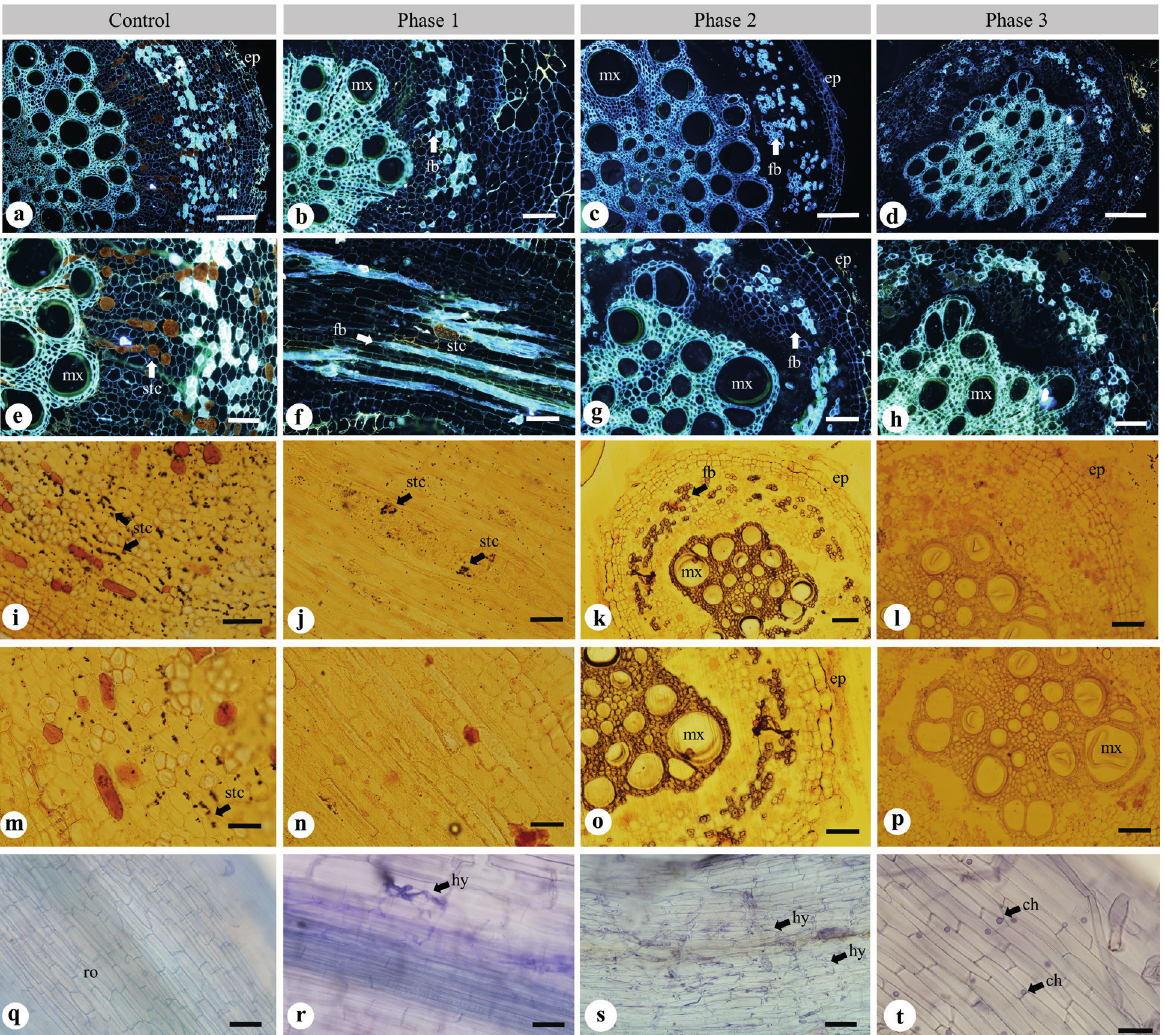
Figure 6 - Anatomical aspects of non-grafted P. edulis in three stages of Fusarium wilt. ( a-e ): fluorescence microscopy of the root of control plants not inoculated showing the presence of fibers and starch. ( b-f ): first wilt stage with marked reduction in the presence of starch and absence of callus. ( c-g ): absence of starch and callus and lower fluorescence of the fibers. ( d-h ): absence of starch with disintegration of tissues. ( i-m ): root control with presence of starch in the cortical parenchyma. ( j-n ): low starch concentration in the first wilt stage ( k-l, o-p ): absence of starch in the parenchyma of the cortex and vascular system. ( q ): control plant root with absence of pathogen. ( r-t ): presence of intracellular hyphae and chlamydospores. hy: hyphae, ch: chlamydospores, ro: root, ep: epidermis, stc: starch, mx: metaxylem, fb: fibers. Bars: ( a, c, d ) = 250 μm ( k ) = 125 μm ( b, e-i, l, o, p, s ) = 100 μm ( j, m, n, q, r, t ) = 50